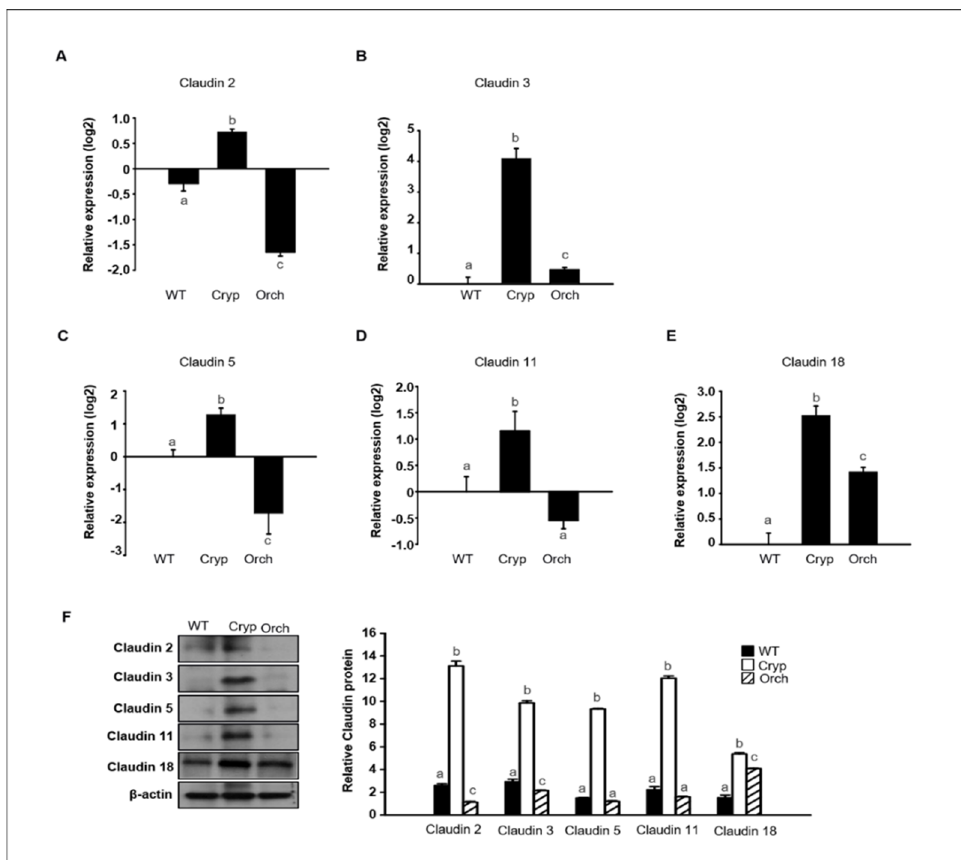
Figure 6. The relative expression of claudins in wild-type, cryptorchid, and orchiopexied dog testes. The expression of ( A ) claudin-2, ( B ) claudin-3 , ( C ) claudin-5 , ( D ) claudin-11 , and ( E ) claudin-18 genes were detected in wild-type, cryptorchid, and orchiopexied dog testes. The expression levels of these genes are significantly increased in cryptorchid testes compare to wild-type. Data are presented as means ± standard deviation. Values with different letters are significantly different ( F ) protein levels of claudins 2, 3, 5, 11, and 18 were also analyzed via immunoblot analysis. The values of all protein levels were normalized to that of β -actin. Results are expressed as mean ± standard deviation. Values with different letters are significantly different. These results are consistent with the data from our qPCR analysis.